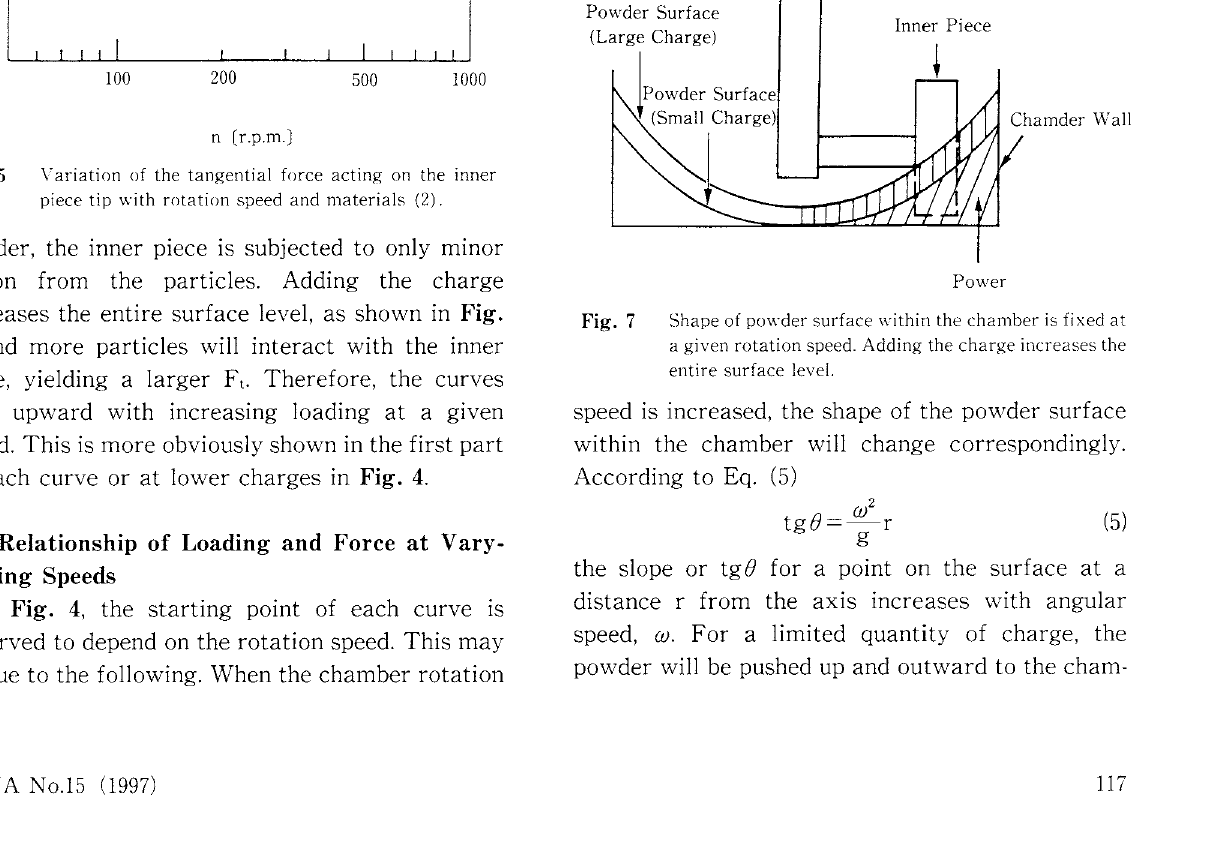
Variation of the radial and tangential forces acting on the inner piece tip with rotation speed (2).